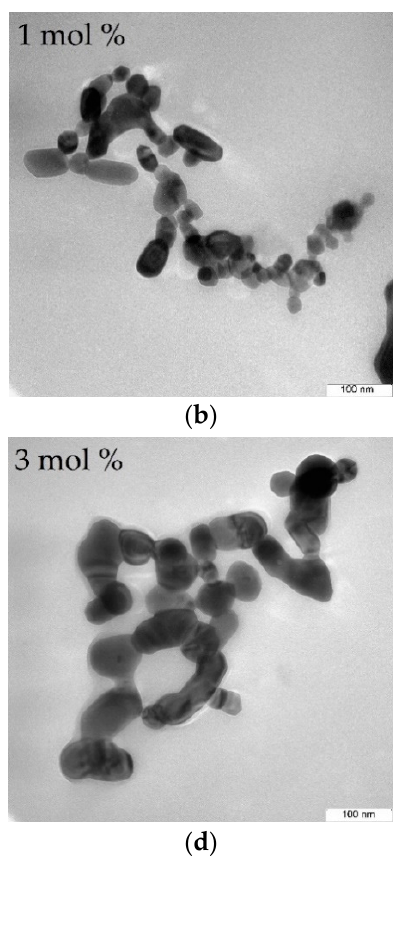
Figure 8. TEM analysis of willemite NPs calcined at different temperatures: ( a ) 500, ( b ) 600, ( c ) 700, ( d ) 800, ( e ) 900, and ( f ) 1000 °C.